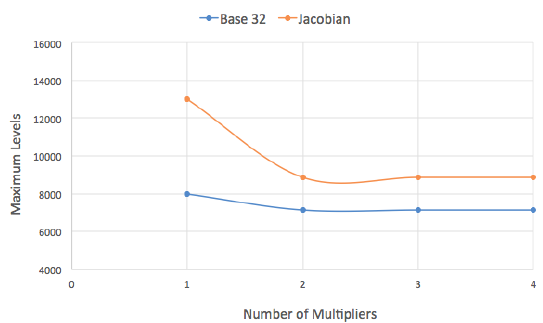
Figure 7. Maximum Levels for Different Number of